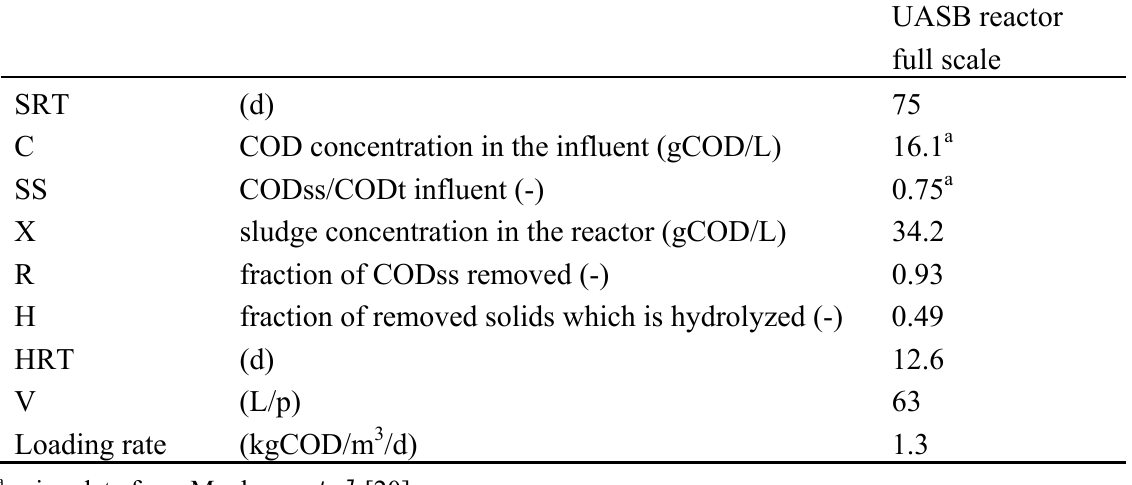
Table 6. Adjusted design values for the UASB